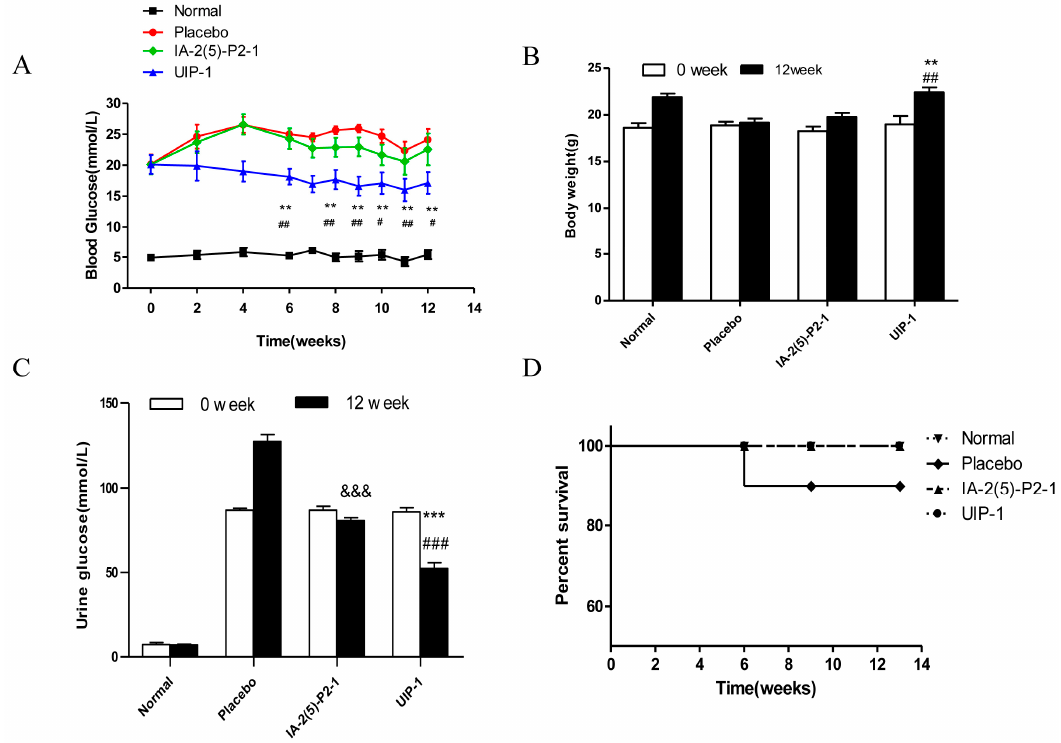
Figure 1. Glucose metabolism was improved by the novel UIP-1 (U-IA-2(5)-P2-1) peptide vaccine in C57BL/6J mice. ( A ) Eight-hour fasting blood glucose concentrations were monitored by glucometers in C57BL/6J mice ( n = 10 for each group); ( B ) The mean body weight throughout the observation period ( n = 10 for each group); ( C ) The varieties of urine glucose; ( D ) The survival time of each group was recorded in the study. Values are expressed as the mean ± SEM of data. ** p < 0.01, *** p < 0.001; UIP-1 versus placebo group. # p < 0.05, ## p < 0.01, ### p < 0.001; UIP-1 versus IA-2(5)-P2-1 group. &&& p < 0.001; IA-2(5)-P2-1 versus placebo group, one-way ANOVA.